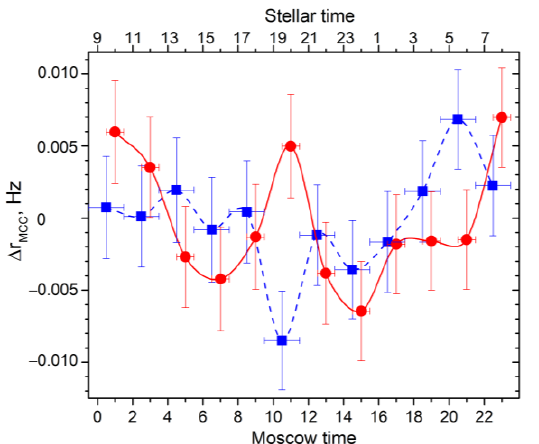
Figure 6. The variation curves obtained for solar day (red line and lower scale) and sidereal day (blue line and upper scale).